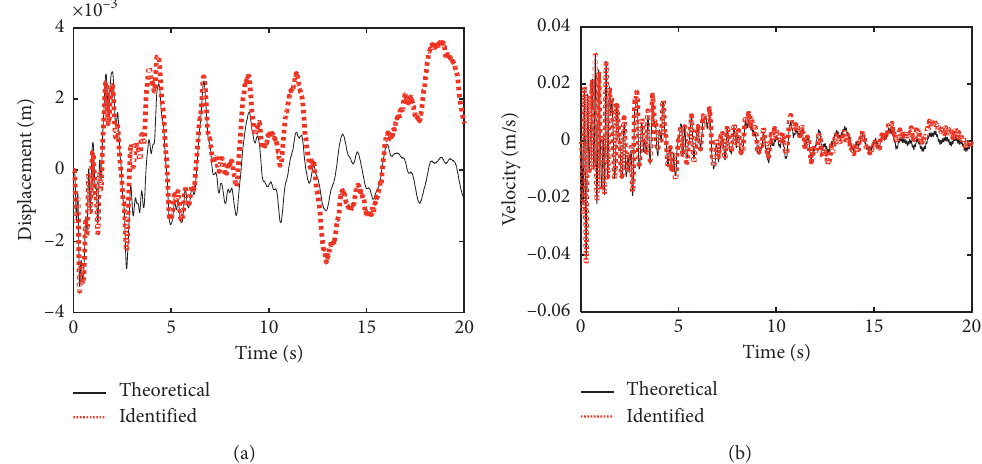
Figure 12: (a) Theoretic and determined vertical shift at node 7 with a larger R